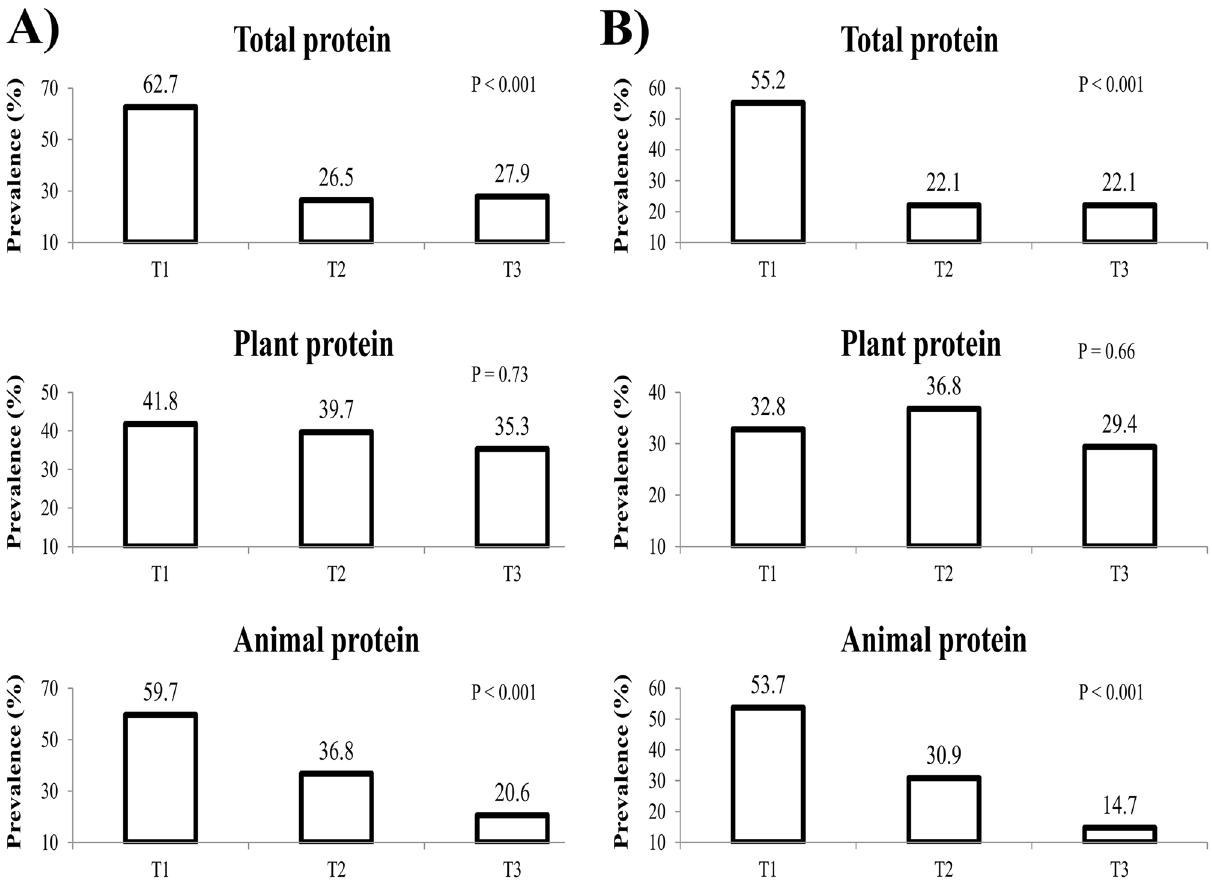
Figure 1. Prevalence of MUO across tertiles of dietary total, plant, and animal protein intake in the study population. ( A ) MUO based on IDF definition. ( B ) MUO based on IDF/HOMA-IR vs. 62.7%; P < 0.001), and animal protein intake (20.6 vs. 59.7%; P < 0.001), compared to the first tertile. According to IDF/HOMA-IR definition, adolescents had lower prevalence of MUO in the top tertile of dietary total (22.1 vs. 55.2%; P < 0.001), and animal protein intake (14.7 vs. 53.7%; P < 0.001). However, there were not significant differences in the prevalence of MUO across tertiles of dietary plant protein intake considering IDF (P = 0.73) or IDF/HOMA-IR (P = 0.66) criteria. Mean (± SD) consumption of dietary total, plant and animal protein was 14.3 (± 2.0), 7.3 (± 1.6), and 7.0 (± 2.0) percent of the total energy intake, respectively. Adolescents’ dietary intakes of selected nutrients and food groups across tertiles of dietary total protein intake are shown in Table 2. Participants in the top tertile of total protein intake, compared to those in the first tertile, had a higher consumption of plant protein, animal protein, saturated fatty acids, fiber, red meats, vegetables, fruits, nuts, legumes and dairy. However, carbohydrates and grains intake was lower among the individuals in the highest tertile of total protein intake compared to the low- est one. Total energy and total fat intake were not substantially different between participants in the top and the bottom tertiles of total protein intake. Table 3 and Fig. 2 provide crude and multivariable-adjusted odds ratios for MUO across tertiles of total, plant, and animal protein intake considering IDF criteria. Individuals in the top tertile of dietary total protein intake had lower odds of being MUO in crude (OR 0.23; 95% CI 0.11–0.48) and maximally-adjusted (OR 0.32; 95% CI 0.13–0.77) models compared to those in the bottom category. In the case of plant protein intake, there was not a significant association between the top tertile of dietary intake and possibility of being MUO (OR for T3 vs. T1: 0.76; 95% CI 0.38–1.52) in the crude model. However, after controlling all of the possible confounders this association became stronger and statistically significant (OR 0.30; 95% CI 0.10–0.91). Furthermore, participants in the last tertile of animal protein intake had lower odds of MUO in crude (OR for T3 vs. T1: 0.18; 95% CI 0.08–0.38) and fully-adjusted (OR for T3 vs. T1: 0.20; 95% CI 0.08–0.54) models. A significant trend was observed for MUO across tertiles of dietary total, plant, and animal protein intake after considering all confounders. Furthermore, each SD increase in dietary total and animal protein intake was respectively associated with 31%, and 37% reduced odds of being MUO in the fully-adjusted model. However, no significant linear association was seen between dietary plant protein intake and chance of being MUO. Crude and multivariable-adjusted odds ratios for MUO (based on IDF/HOMA-IR definition) across tertiles of total, plant, and animal protein intake are presented in Table 4 and Fig. 2. Adolescents in the third tertile of dietary total protein intake were less likely to be MUO in the crude model (OR 0.23; 95% CI 0.11–0.49) compared